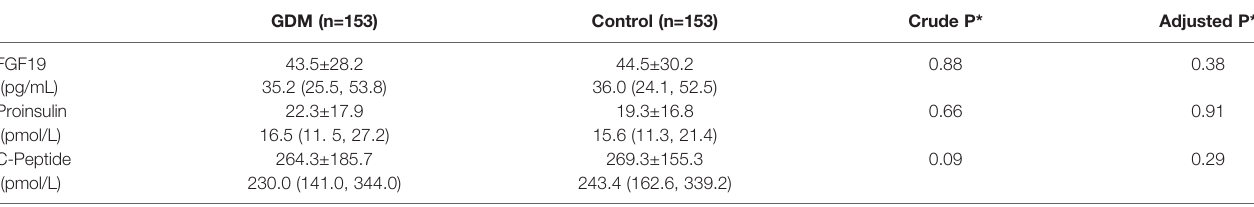
TABLE 1 | Cord plasma FGF19, proinsulin and C-peptide concentrations in the newborns of GDM versus euglycemic (control) mothers (matched by infant sex and gestational age) in the Shanghai Birth Cohort. GDM